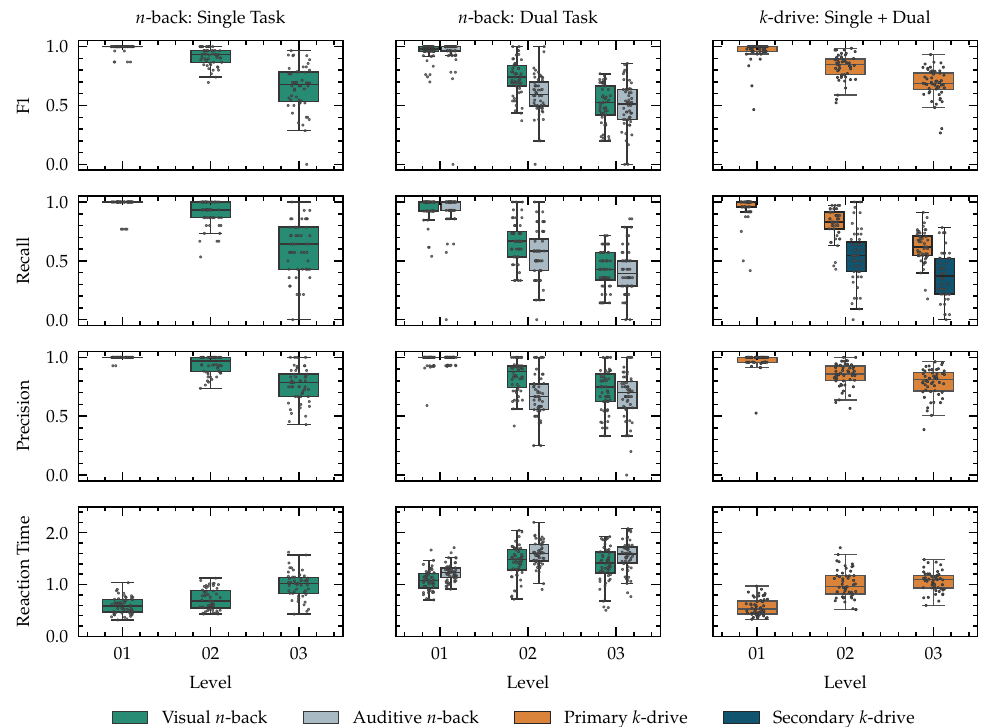
Figure 11. Recorded performance metrics during all conducted tests. For single-task n -back per- formance, we report F 1-score, recall, precision and reaction time ( first column ). If a dual task was executed, we report these results as an additional box for the corresponding level ( second column ).